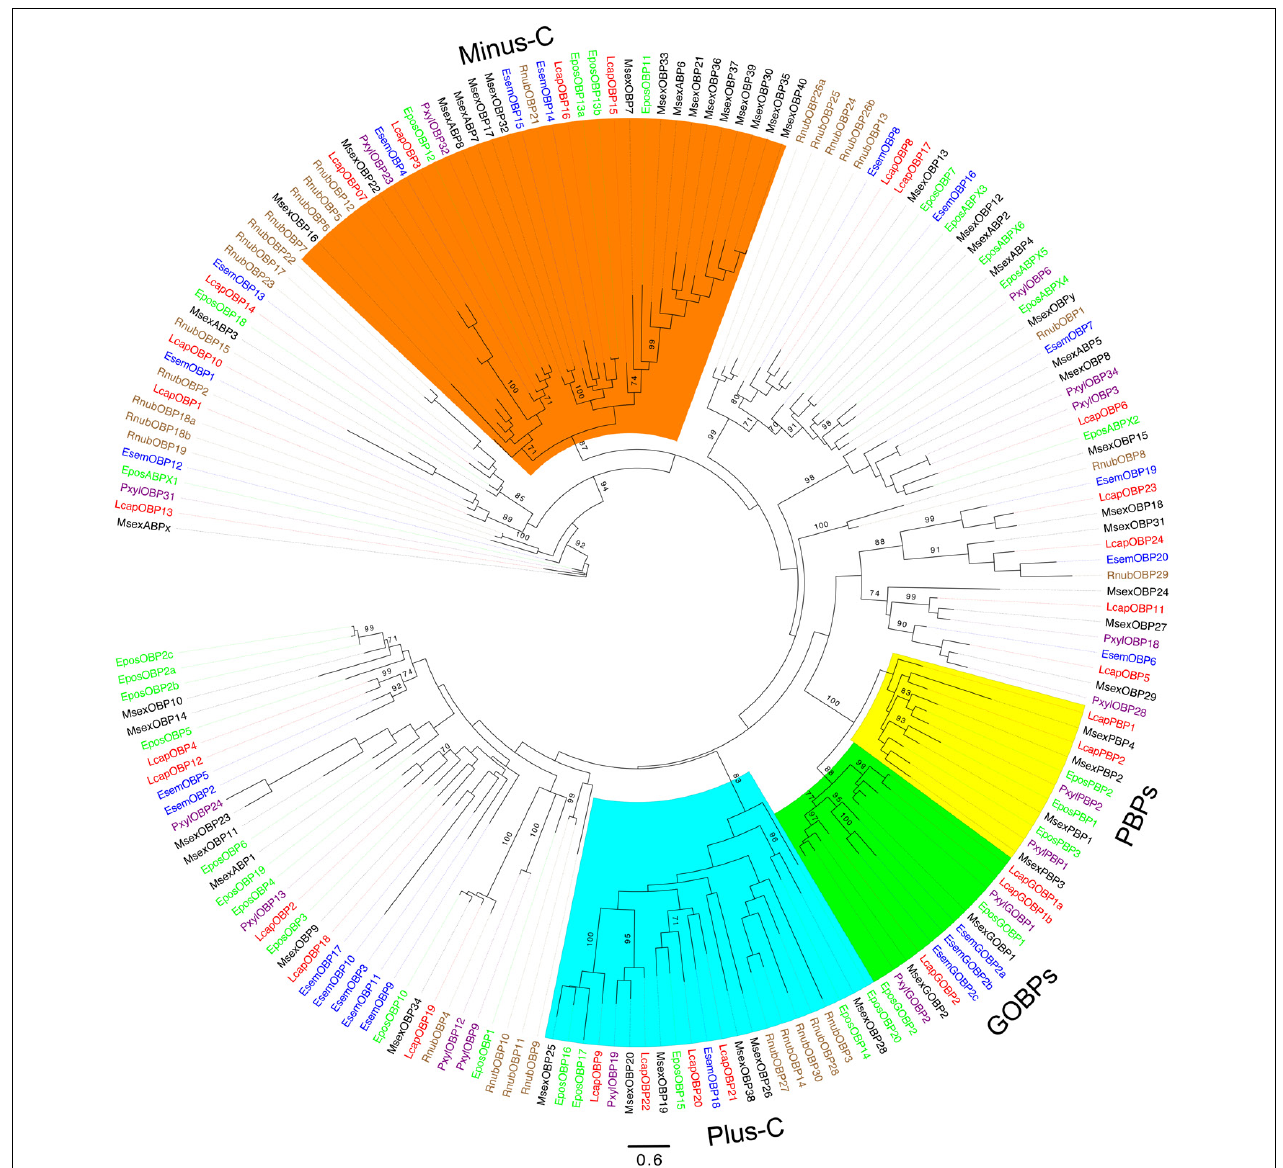
FIGURE 4 | Unrooted maximum-likelihood phylogram of odorant binding proteins (OBPs). Included are sequences from R. nubila (brown), L. capitella (red), E. semipurpurella (blue), E. postvittana (green), M. sexta (black), and P. xylostella (purple). Highlighted subfamilies; pheromone binding proteins, PBPs (yellow), general odorant binding proteins, GOBPs (green), Plus-C OBPs (cyan) and Minus-C OBPs (orange). Bootstrap support values (500 replicates) are indicated on major branches when > 70%. Sources of included OBP sequences, along with their accession numbers (when applicable), are reported in Supplementary Data Sheet S4